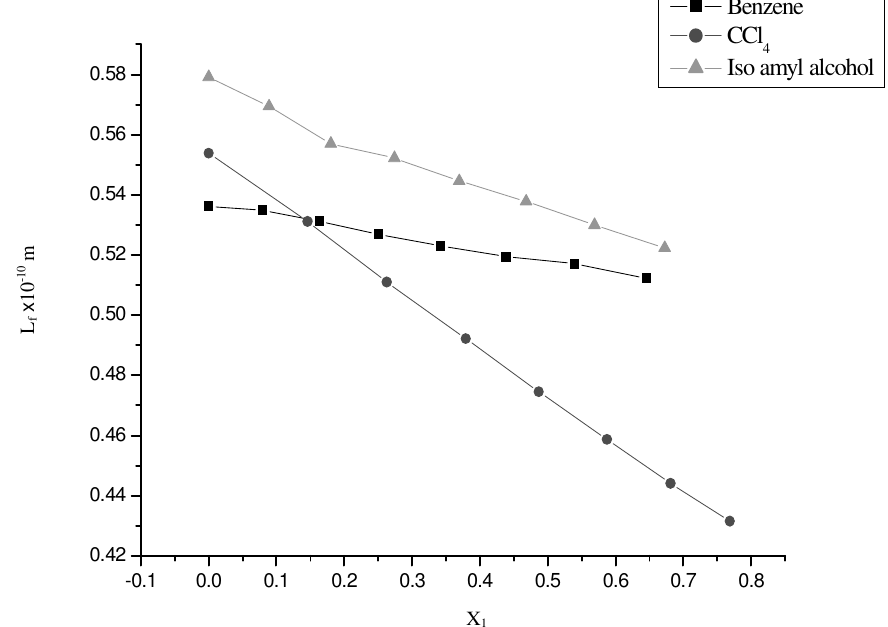
Figure 4. Variation of free length ( L